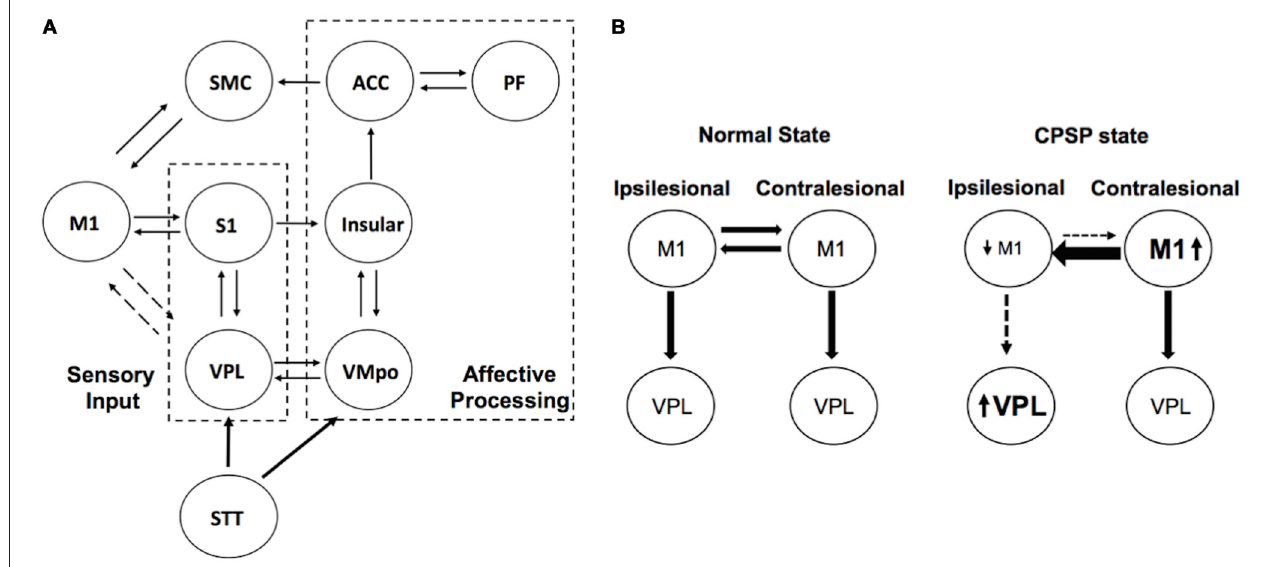
FIGURE 1 | Schema explaining interhemispheric inhibition (IHI) in central post-stroke pain (CPSP). (A) Simplified pain circuit model composed of lateral and medial thalamic pain pathways. The motor cortex (M1)-VPL connection is described as dotted lines as there is an indirect connection. It should be also noted that there is an indirect somatosensory projection from the S1 to insular cortex through posterior parietal cortex (Price, 2000). (B) Impaired descending inhibition pathways from primary M1. Ipsilesional M1 activity is decreased due to not only stroke lesion but also inhibitory signals from the contralateral M1. ACC, anterior cingulate cortex; PF, prefrontal; SMC, supplementary motor cortex; STT, spinothalamic tract; VMPo, posterior ventromedial nucleus of the thalamus; VPL, ventral posterolateral nucleus of the